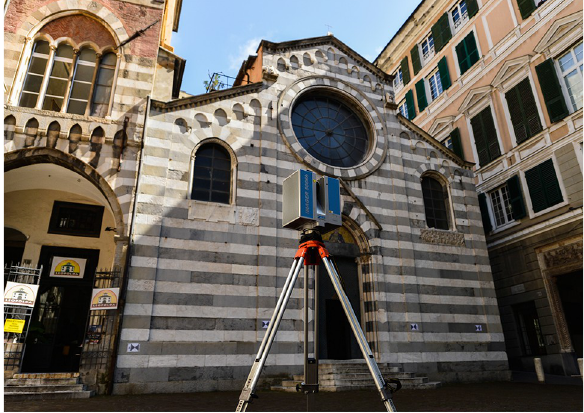
Figure 7. Scan position to acquire the point cloud of the Chiesa of S. Matteo facade (R. Lavezzaro)